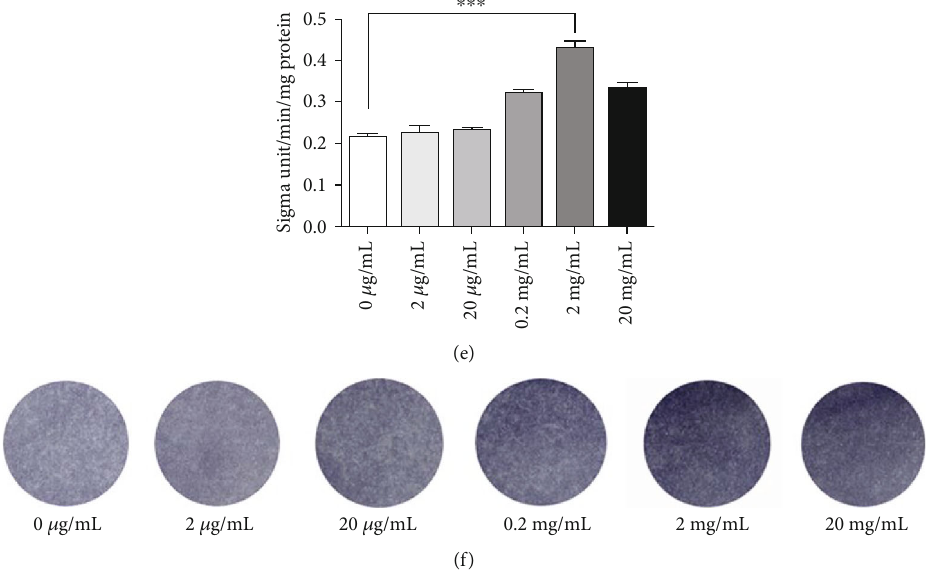
Figure 2: Optimal concentration of DIM for the following experiments. (a, b) Primary BMMSCs. Scale bars = 100 μ m (a) and 200 μ m (b). (c) BMMSCs in passage 3. Scale bars = 200 μ m . (d) XRD pattern of DIM. (e) ALP activity detection after BMMSCs were treated with 0 μ g/mL, 2 μ g/mL, 20 μ g/mL, 200 μ g/mL, 2mg/mL, and 20mg/mL DIM on the 3rd day, respectively. ∗∗∗ P < 0 : 001 . (f) ALP staining after BMMSCs were treated with 0 μ g/mL, 2 μ g/mL, 20 μ g/mL, 200 μ g/mL, 2 mg/mL, and 20mg/mL DIM on the 5th day,